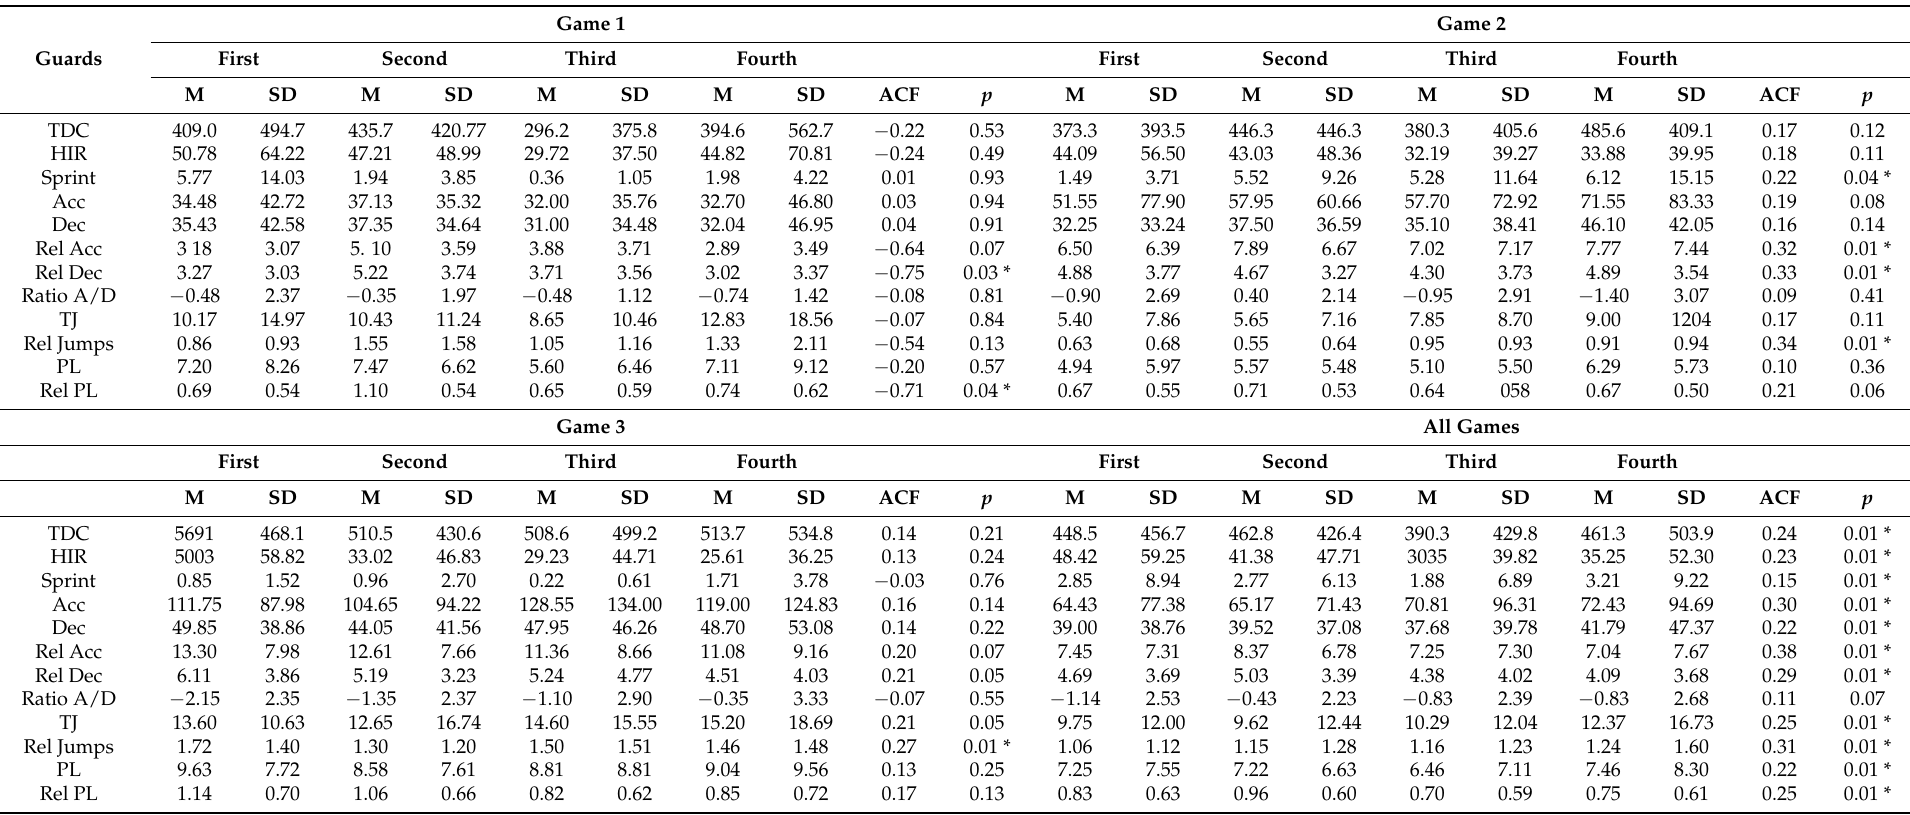
Table 2. Descriptive statistics for physical demands during games and quarters for guard players (persistency of performances via ACF and p -values). Game Guards